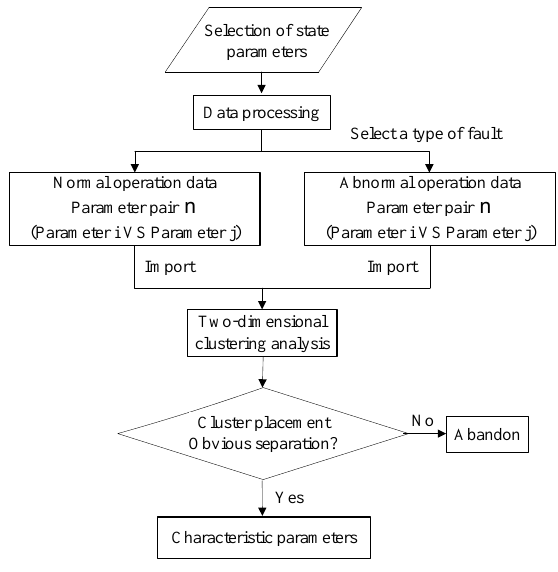
Figure 1. Feature extraction flow chart.